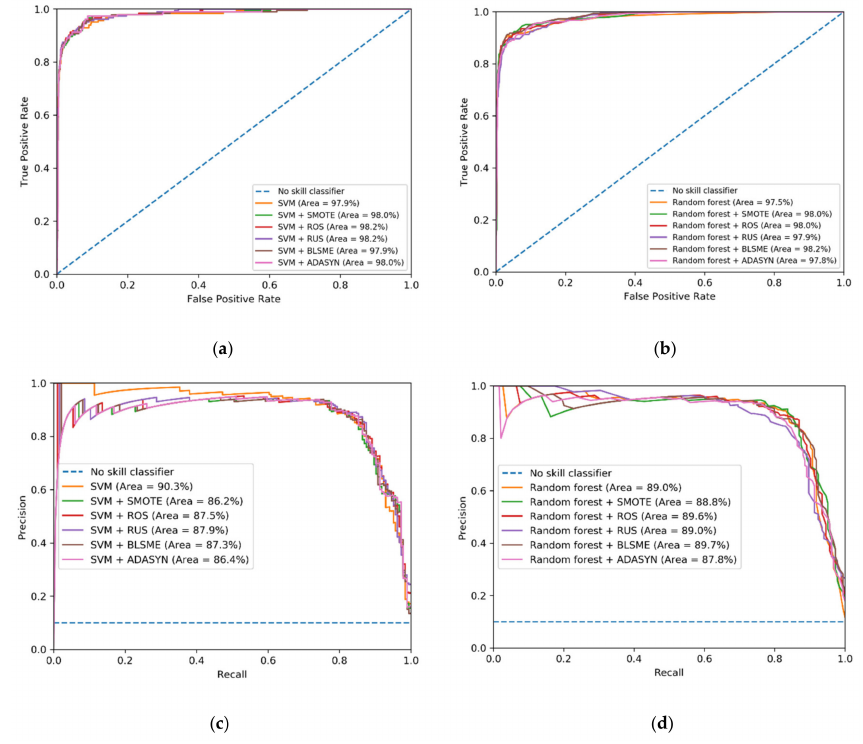
Figure A3. The ROC and PR curves of SVM and Random Forest for Fold 2; ( a ) the ROC curve of SVM; ( b ) the ROC curve of Random Forest; ( c ) the PR curve of SVM; and, ( d ) the PR curve of Random